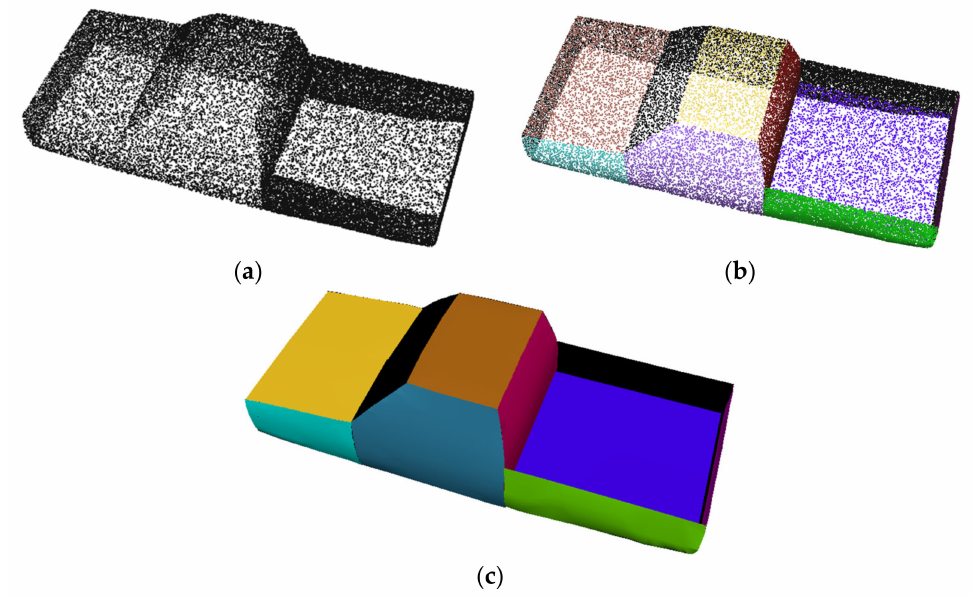
Figure 12. ( a ) The point cloud of a truck; ( b ) segmented subsets; ( c ) reconstructed PDE-based